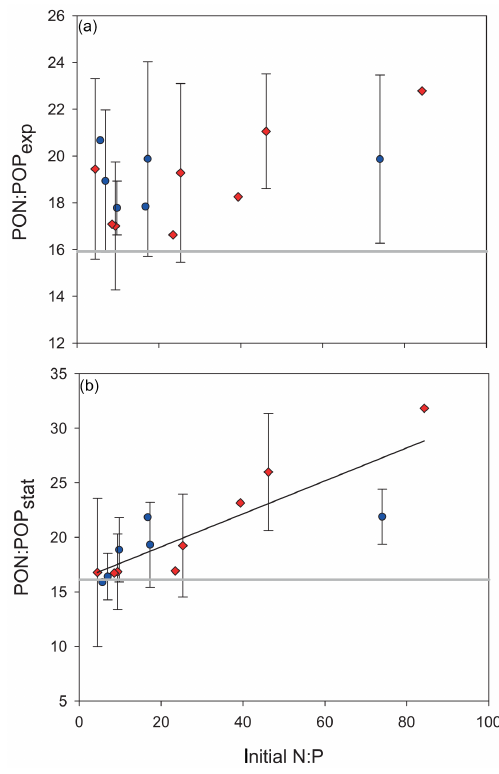
Figure 5. Temporal development of DOP with standard deviations depicted as shaded error